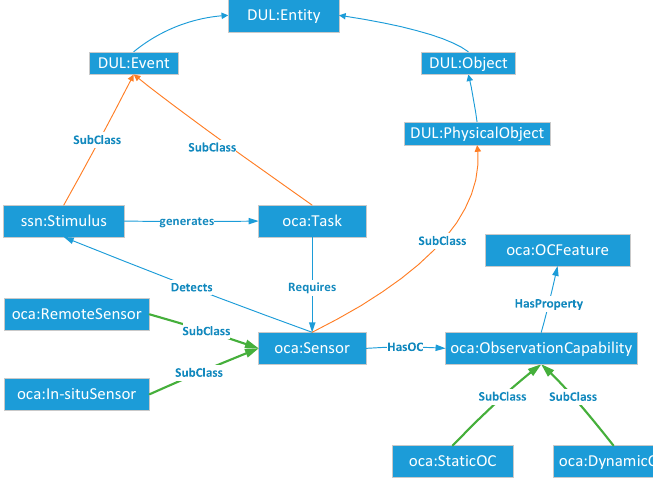
Figure 4. Core classes of the sensor module.